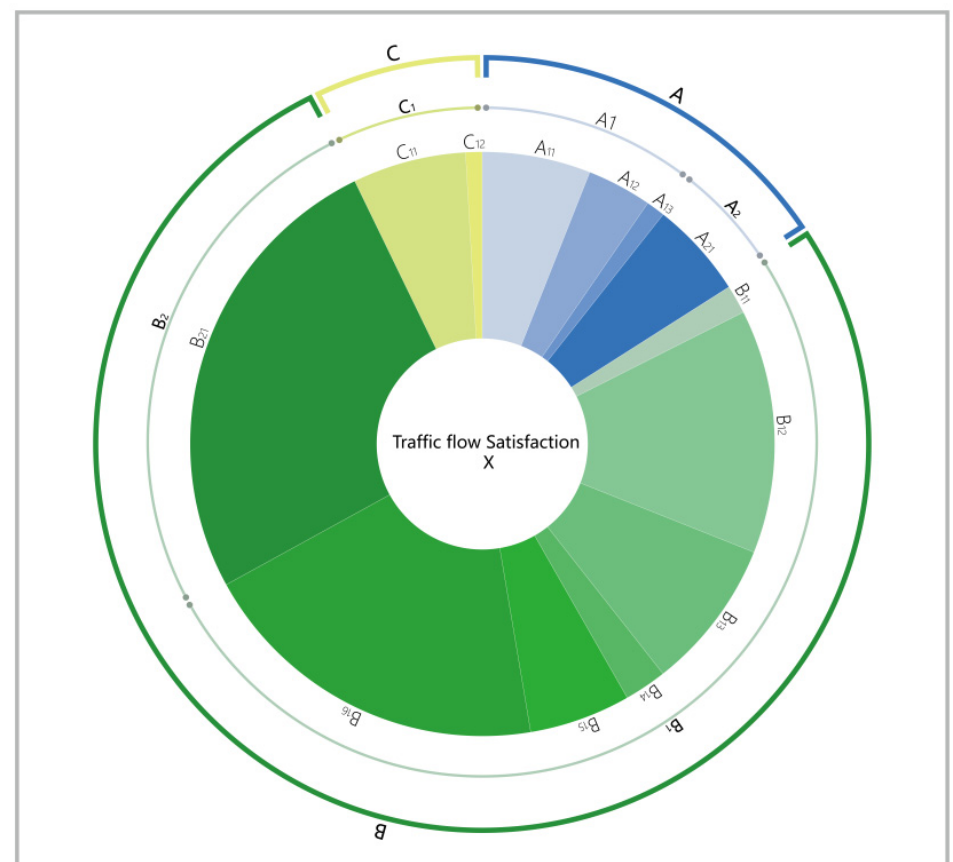
Figure 9. The index weight of the comprehensive evaluation index system.